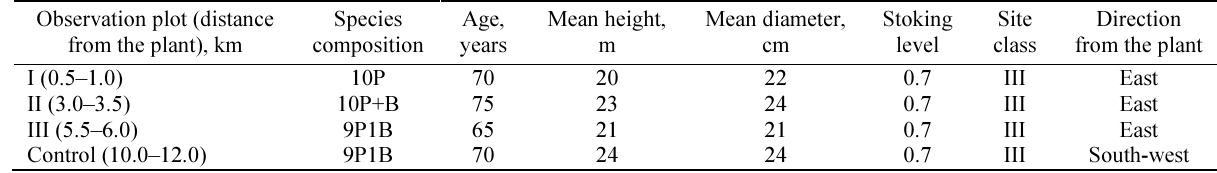
Table 1. Dendrometric characteristics of forest stands at the study sites in the vicinity of “Akmenės cementas” and control Observation plot (distance Species from the plant), km composition